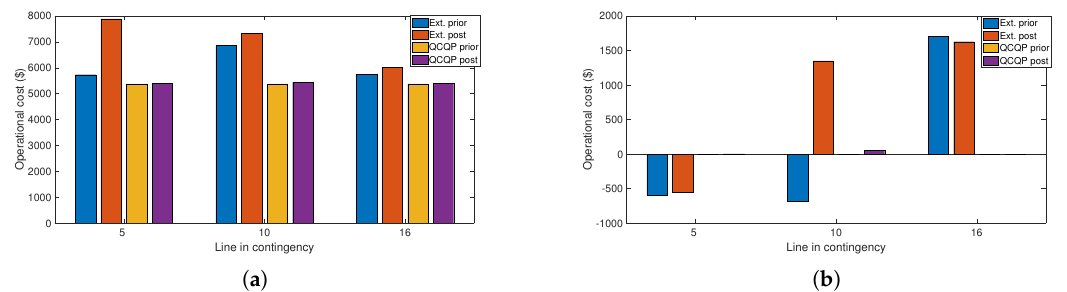
Figure 19. Operational cost for each contingency and each strategy proposed, prior to and after the contingency takes place. ( a ) On the left: only thermal generation, ( b ) on the right: thermal generation and PV